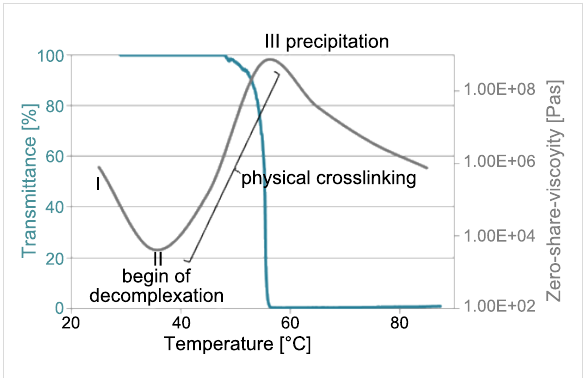
Figure 3: Transmittance [%] and zero-shear-viscosity [Pas] as a func- tion of temperature for a 50 wt % solution of polymer 8 . ( I → II : Viscosity decreases with higher temperature; II → III : Gradual decom- plexation of the polymer, RAMEB-CD molecules slip off from the polymer side chain, aggregates are formed; III : Precipitation of the